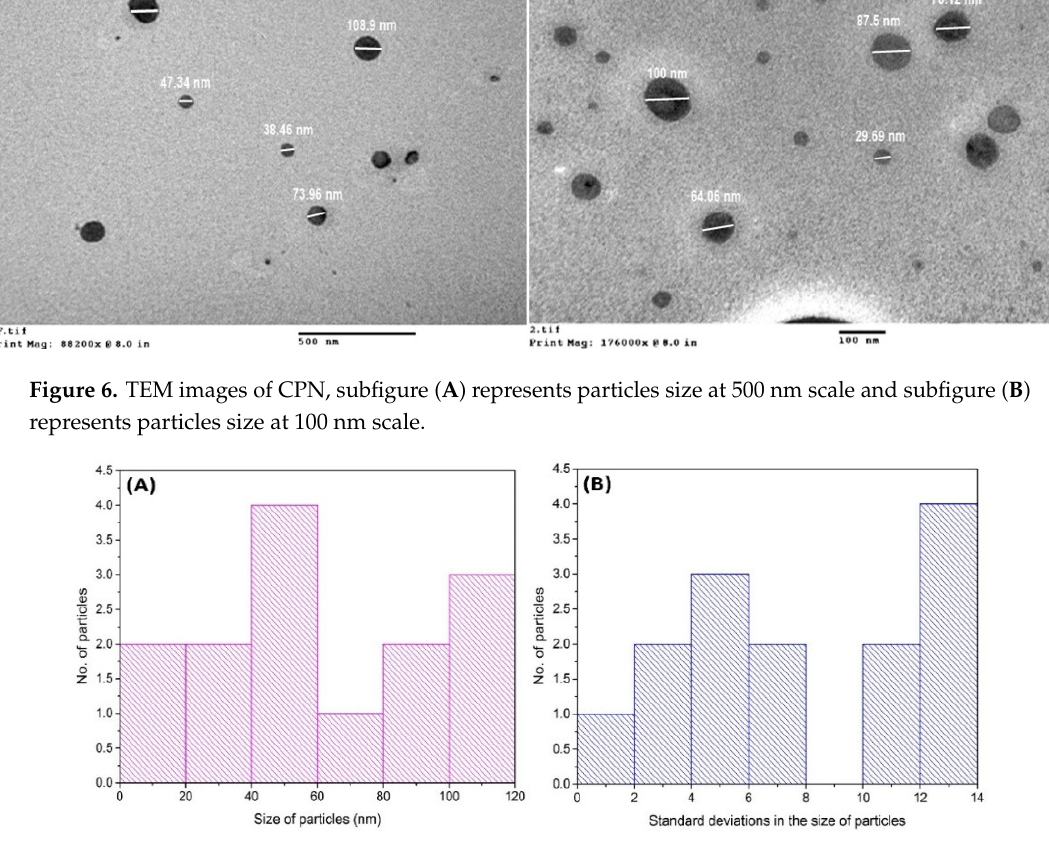
Figure 7. Particle size distribution histogram ( A ) and standard deviation ( B ) graph. Table 5. Arithmetical consideration for